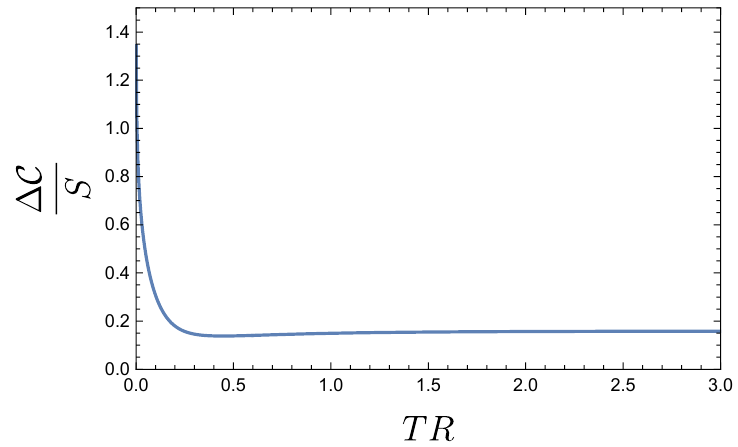
Figure 9 . Complexity of formation divided by the entropy for the planar charged black hole in d = 4. Here we are subtracting the complexity of two copies of the vacuum spacetime (i.e.,the zero mass and zero charge limit of the planar black hole). In this plot, we keep the chemical potential q C J (cid:12)xed as (cid:22)R = 1 . For a (cid:12)xed chemical potential in the limit of zero temperature (dual to C T 2 extremal black hole) the complexity of formation is